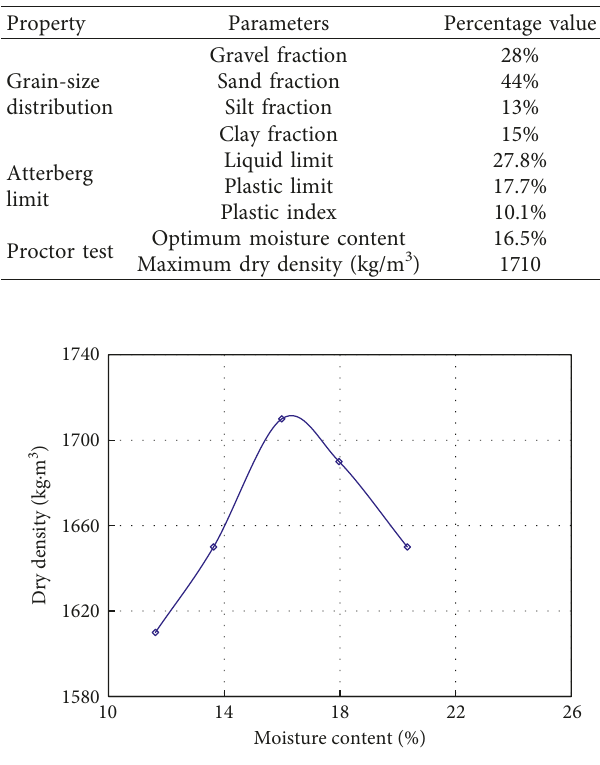
Figure 1: Dry density vs. moisture content at 10%